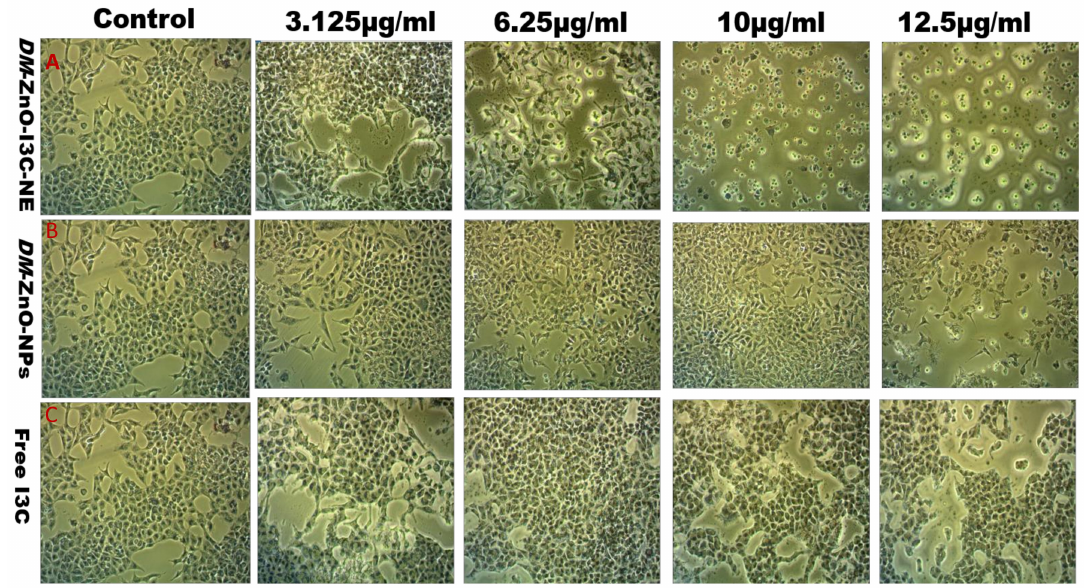
Figure 10. Optical microscopic image for morphology changes of A549 lung cancer cells after treated with DM -ZnO-NE 24 h compared with control. ( a ) DM -ZnO-I3C-NE; ( b ) DM -ZnO NPs; ( c )Free